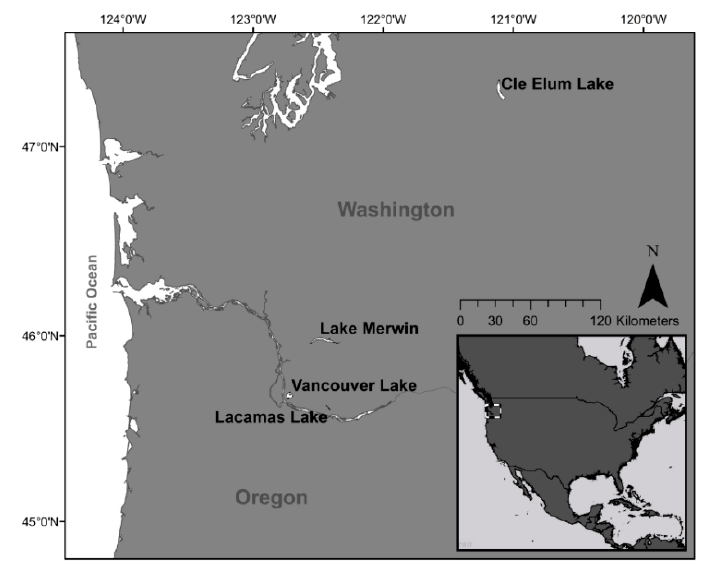
Figure 2. Locations of Cle Elum (oligotrophic), Merwin (oligo-mesotrophic), Lacamas (eutrophic), and Vancouver (hypereutrophic) lakes in Washington state, USA.